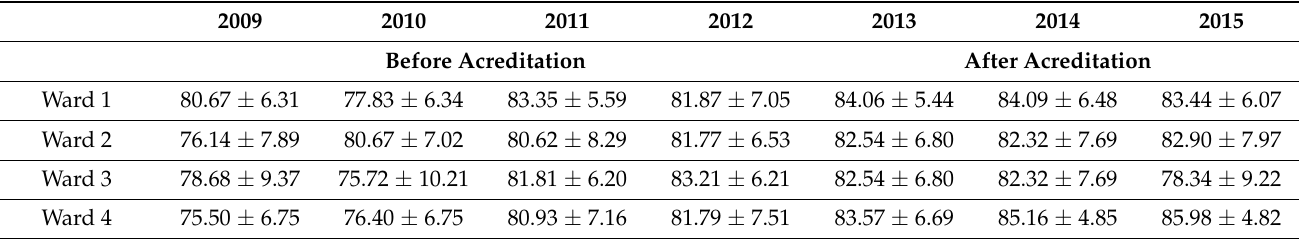
Table 1. Selected descriptive statistics, the number of points for the total assessment for the analyzed departments according to years of analisis.